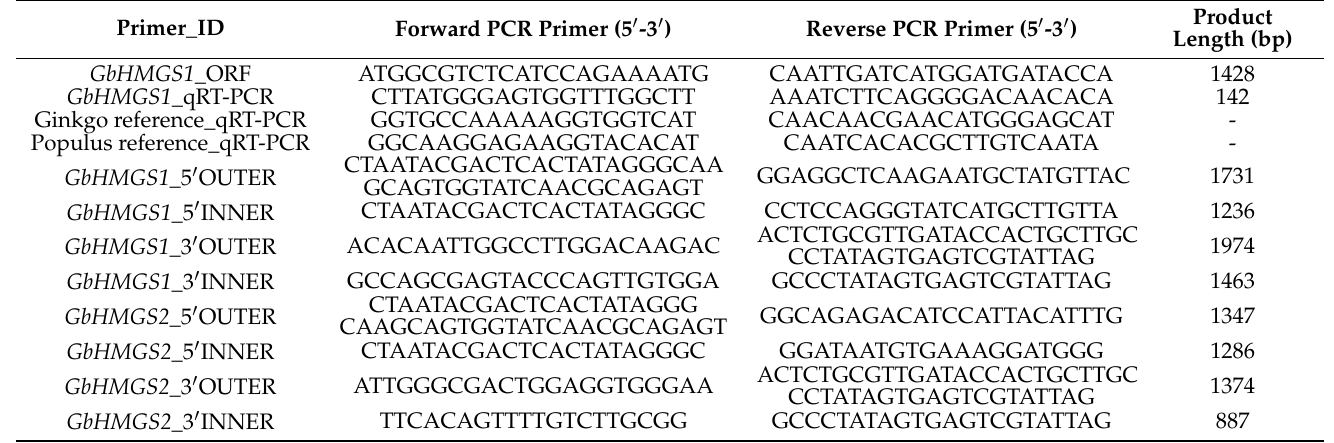
Table 1. Primer sequences for the GbHMGS1 and GbHMGS2